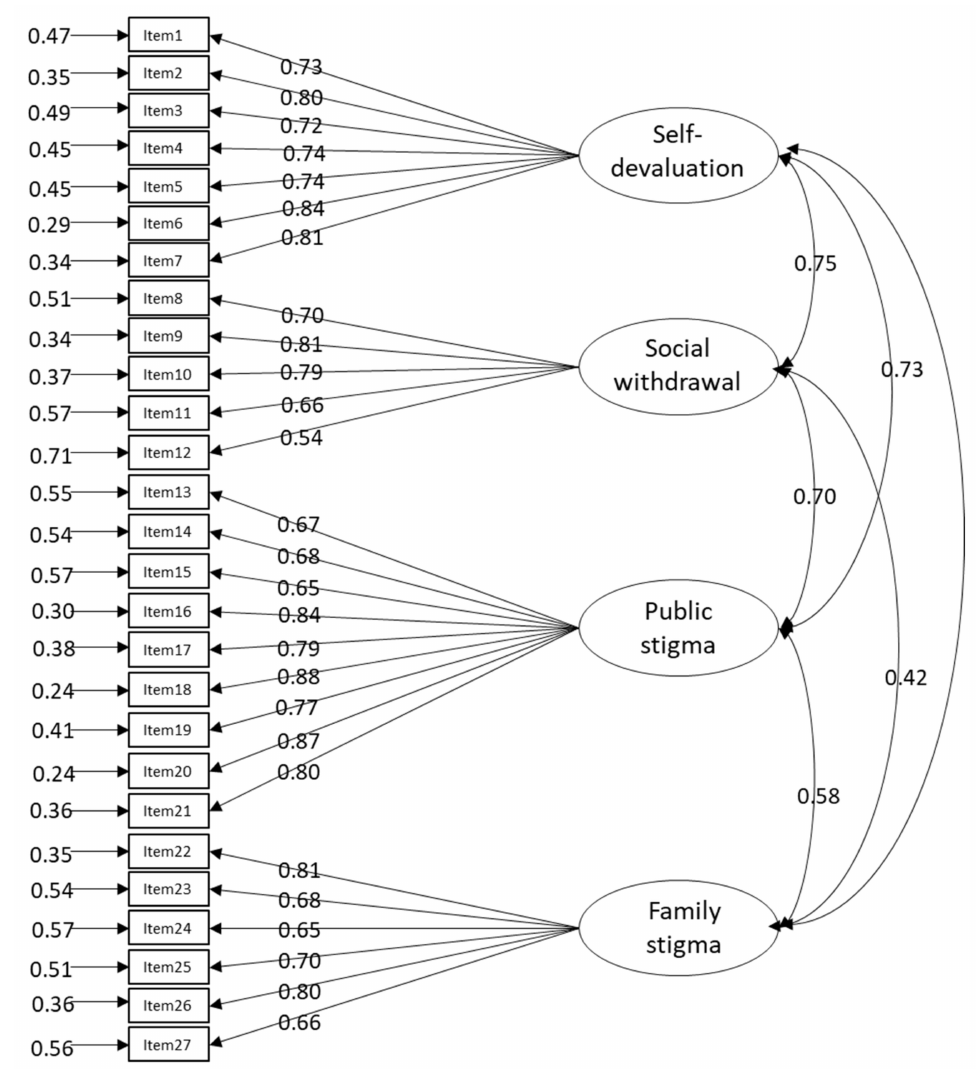
Figure 1. Standardized factor loadings for the ISS.